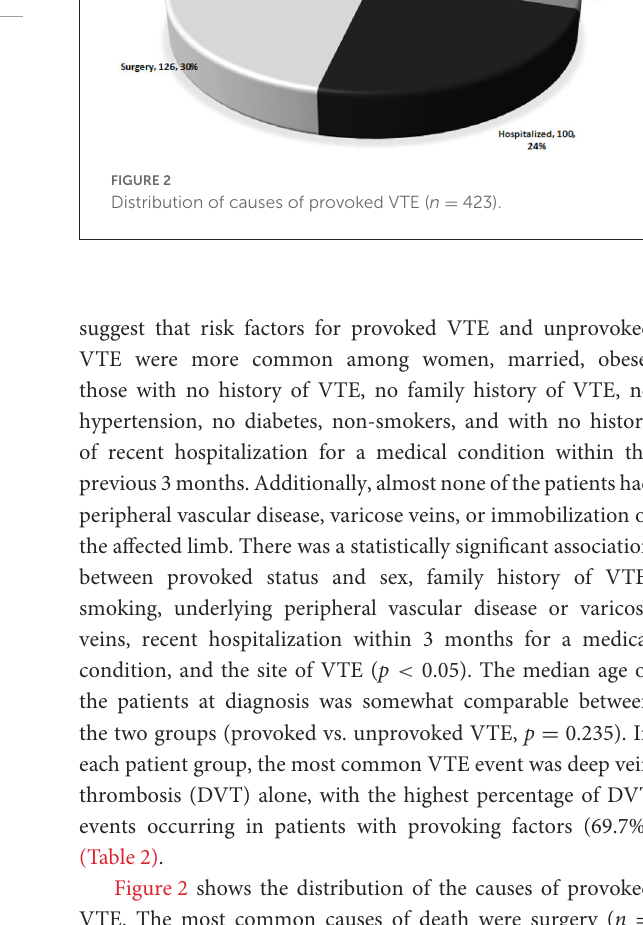
FIGURE2 Distribution of causes of provoked VTE ( n = 423).